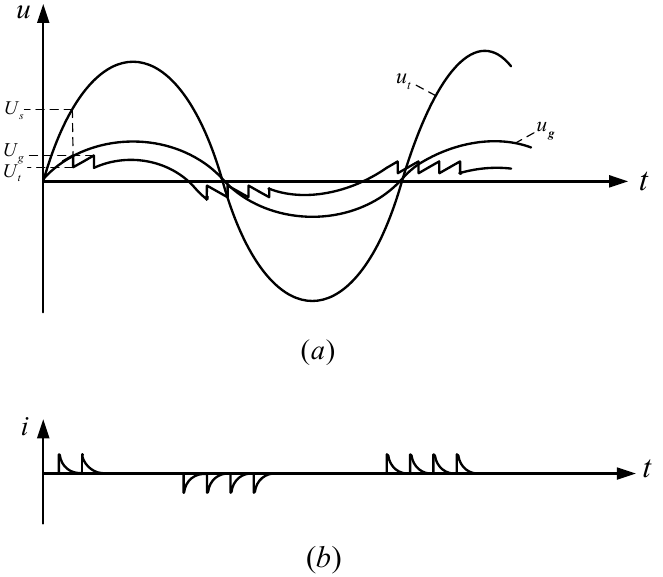
Figure 3. Changes in the air gap during PD. ( a ) Voltage; ( b ) current.